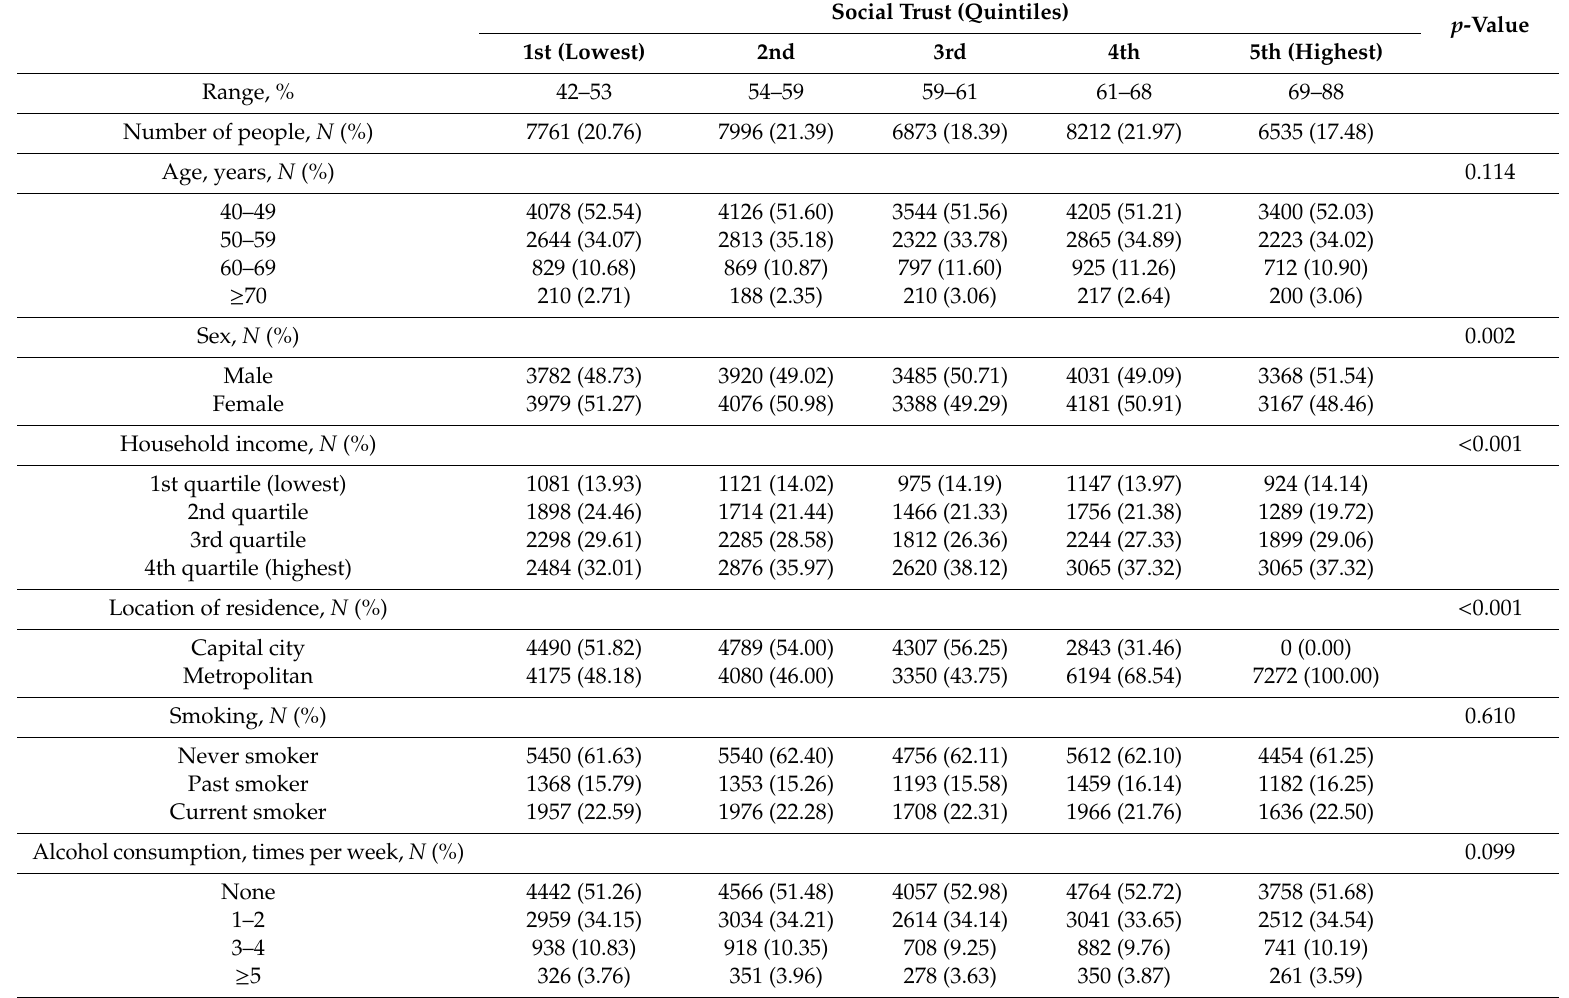
Table 1. Descriptive characteristics of the study